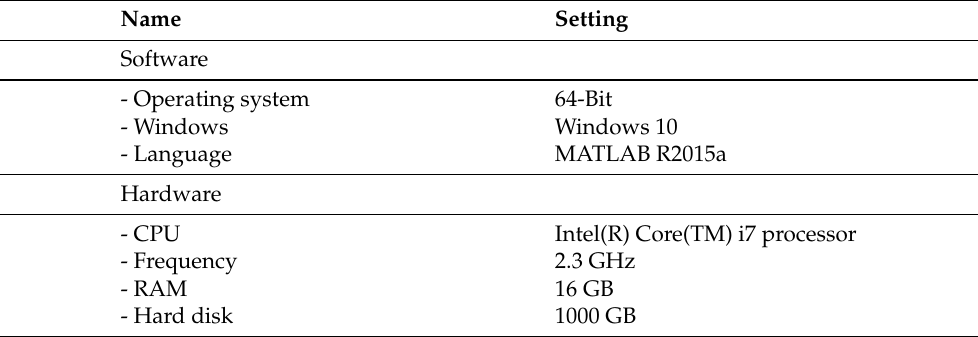
Table 2. Details of the utilized